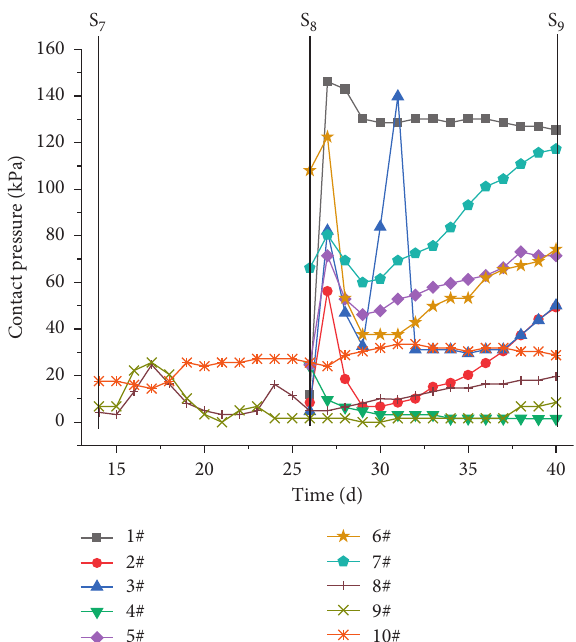
Figure 11: Change curve of DK-190+617 mileage contact pressure in early three tunnels.